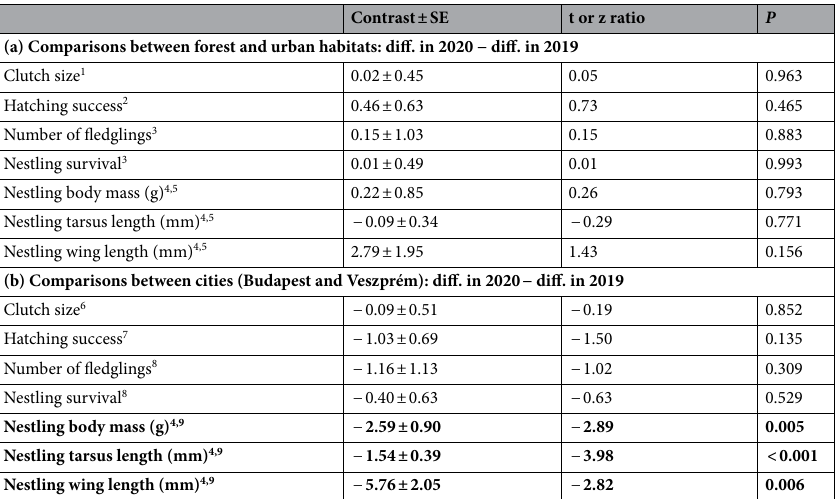
Contrast ± SE t or z ratio P (a) Comparisons between forest and urban habitats: diff. in 2020 − diff. in 2019